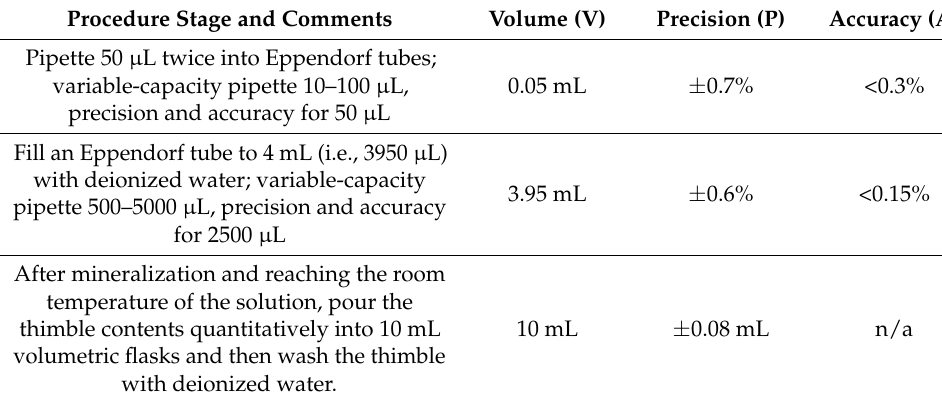
Table 7. Components of the uncertainty budget of the MIP-OES method